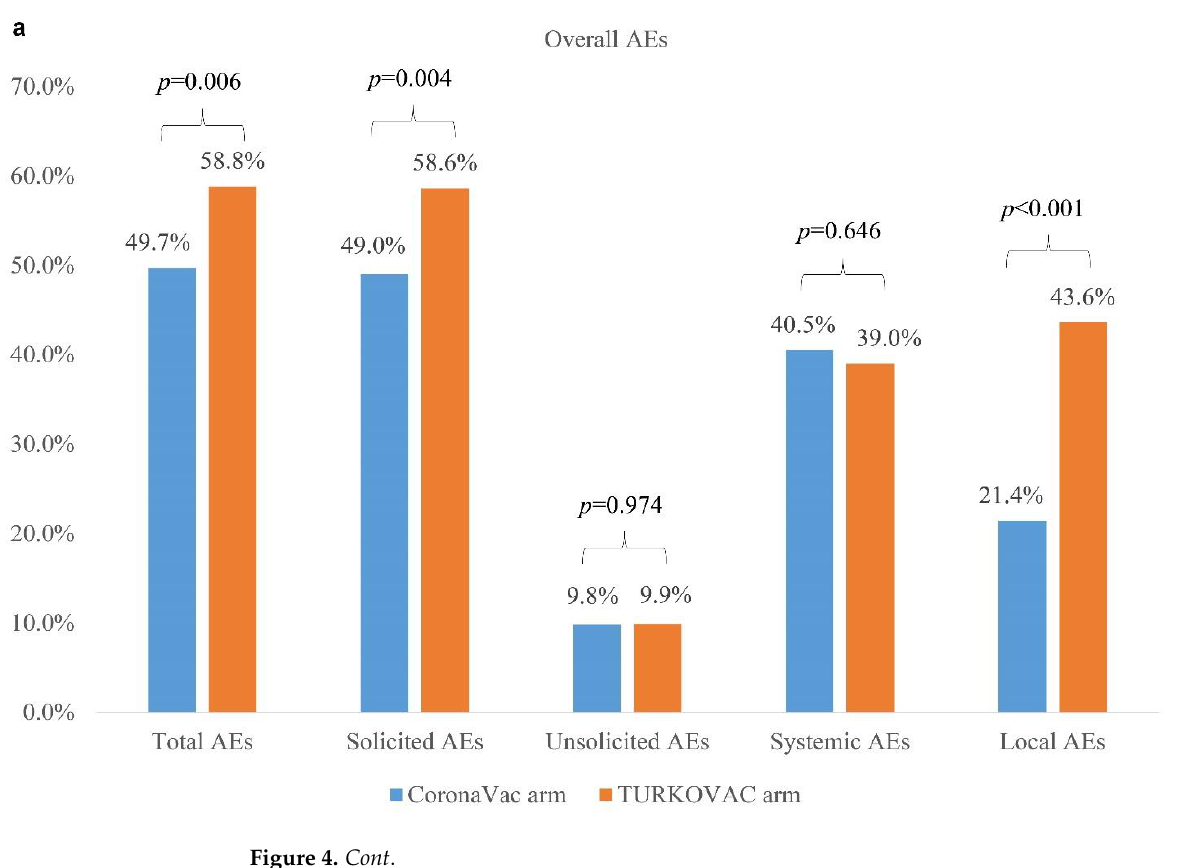
Figure 3. Seropositivity rates in the CoronaVac and TURKOVAC arms 14 days later than the second dose and its distribution according to age and sex: ( a ) for SARS-CoV-2 anti-spike IgG antibodies, ( b ) for pseudovirus neutralization assay. SARS-CoV-2, severe acute respiratory syndrome coronavirus- 2; IgG, immunoglobulin G.